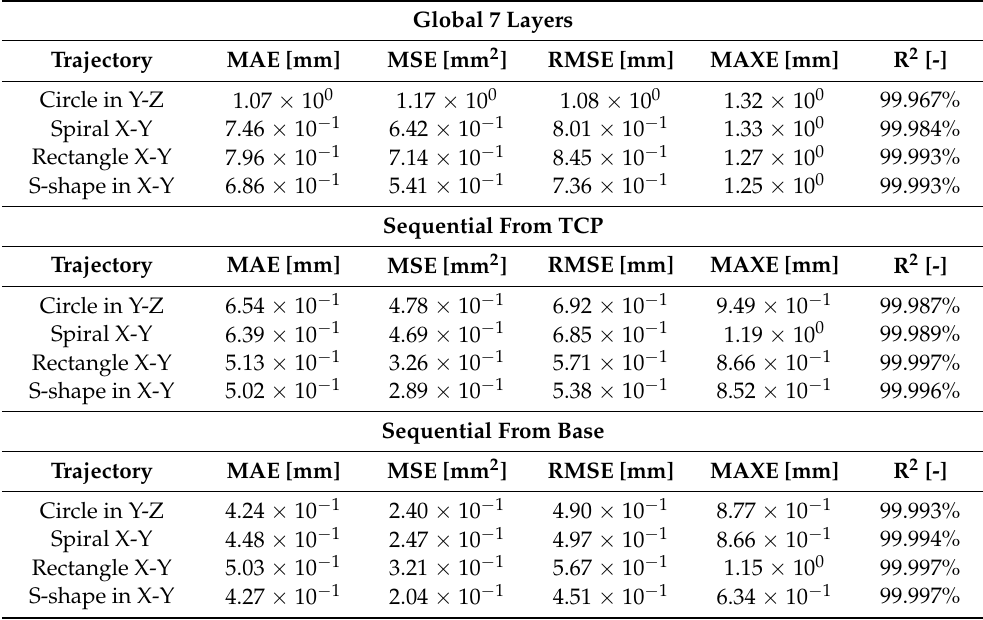
Table 5. Global IK—Sequential IK trajectory error results in the virtual environment: MAE, MSE, MAXE.